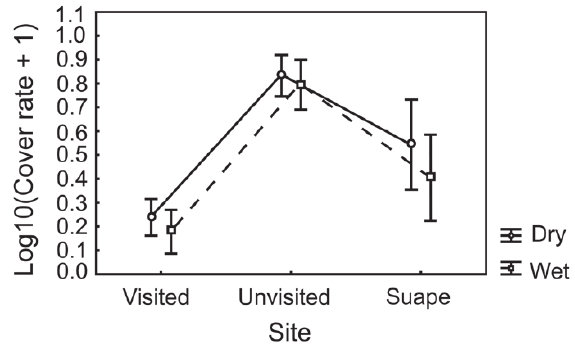
Figure 4 - Comparison of Palythoa caribaeorum cover rate (cm) between visited and unvisited Porto de Galinhas beachrocks and Suape beach during dry and wet seasons. Data were converted in